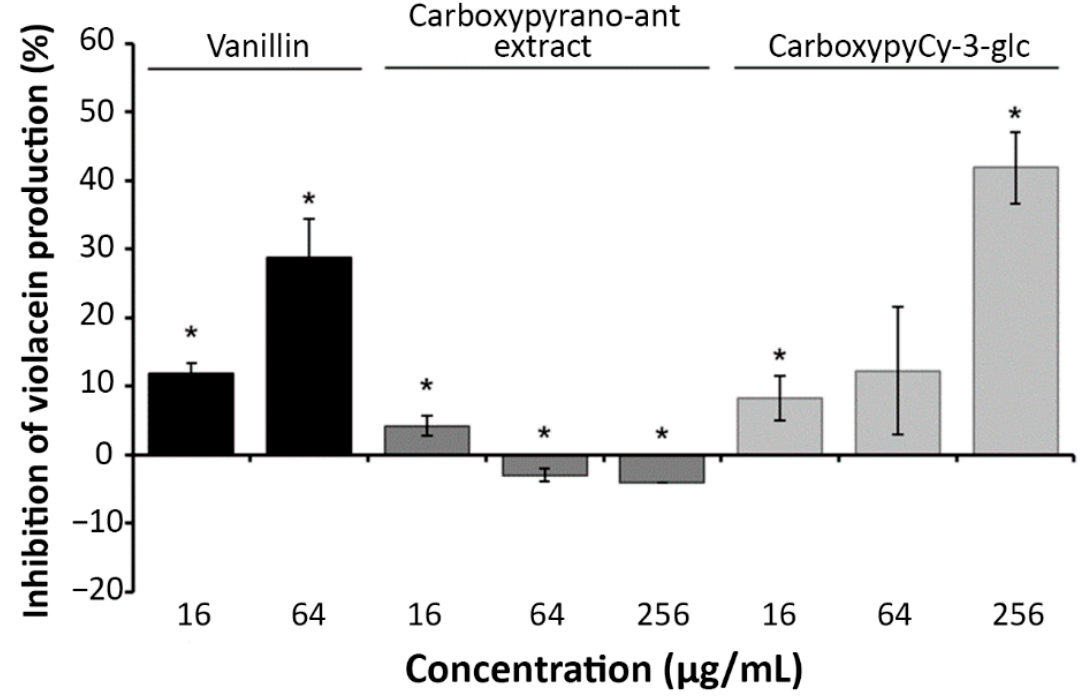
Figure 4. Effect of carboxypyrano-ant extract and carboxypyCy-3-glc on violacein production by C. violaceum ATCC 12472. Vanillin, a known QSI, was included as a positive control. Error bars represent SEM. Differences between the experimental groups and the respective controls were statistically significant for * p < 0.05.